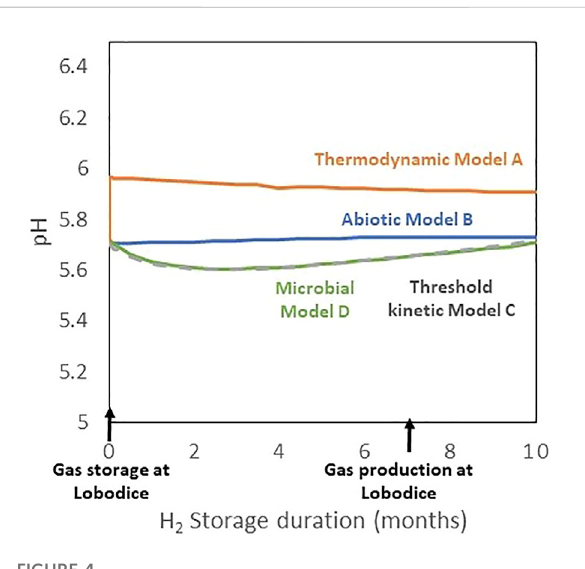
FIGURE 4 Simulated pH evolution during the seasonal storage of town gas at Lobodice, using the different models for describing redox reactions with the oxidation of